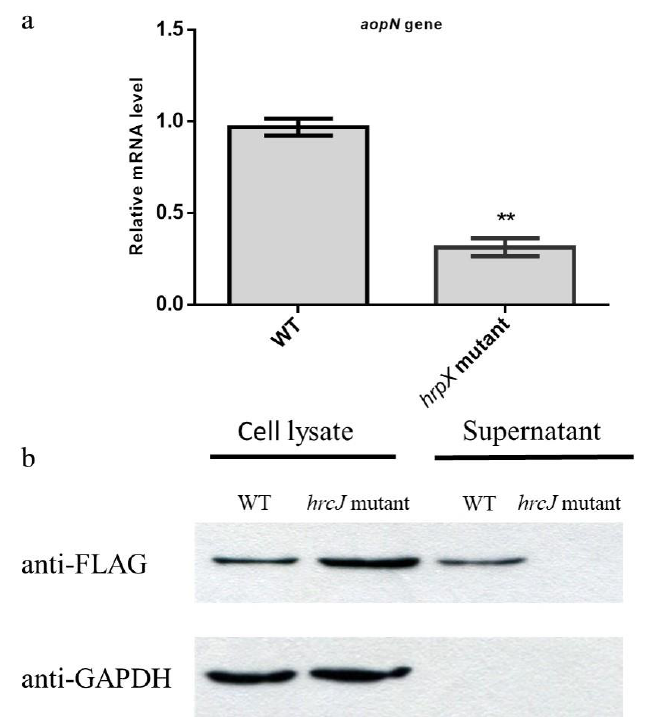
Figure 2. Analysis and identification of AopN as a type III secreted effector. ( a ) Quantitative PCR (qPCR) assays were performed to determine whether aopN was regulated by hrpX. The wild-type (WT) strain and its hrpX mutant were cultured in the T3SS-inducing medium. RNA was extracted and reverse transcribed into cDNA, which was subjected to qPCR assays. The rpoB was used as the internal reference gene [17]. The experiment was performed three times, with similar results obtained each time. Data represent the means ± SD ( n = 3). ** above bars indicate significant differences as determined by t-test, p < 0.05; ( b ) Identification of AopN as a type 3 effector by Western blotting. WT strain Aac5 and its T3SS-deficient hrcJ mutant expressing the AopN-fused FLAG protein was cultured in KB medium until the logarithmic growth phase and then cultured in the T3SS-inducing medium for 4 h. Subsequently, intracellular components and exocrine protein components were extracted and detected using the anti-FLAG antibody. Signals were detected in the intracellular component of the WT and hrcJ , as well as the supernatant of the WT, but no signal was detected in the exocrine component of hrcJ mutant carrying the AopP-FLAG. The antibody GAPDH was used as the internal reference protein [17]. The experiment was performed three times, with similar results obtained each time.